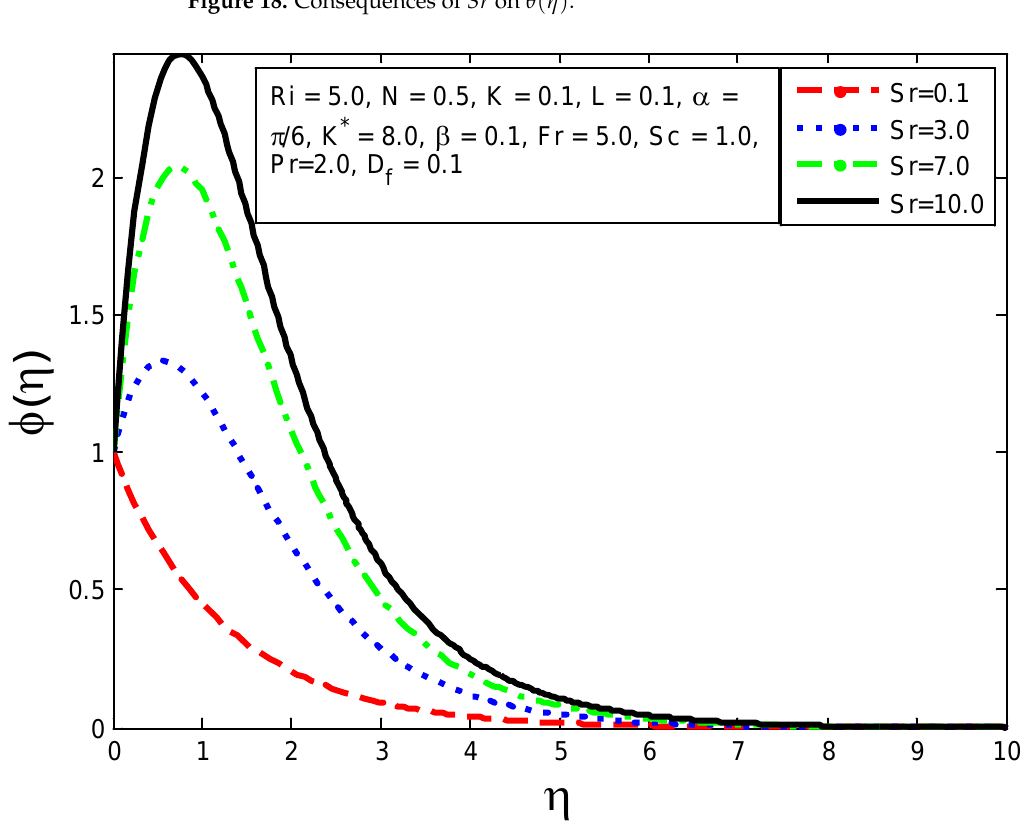
Figure 18. Consequences of